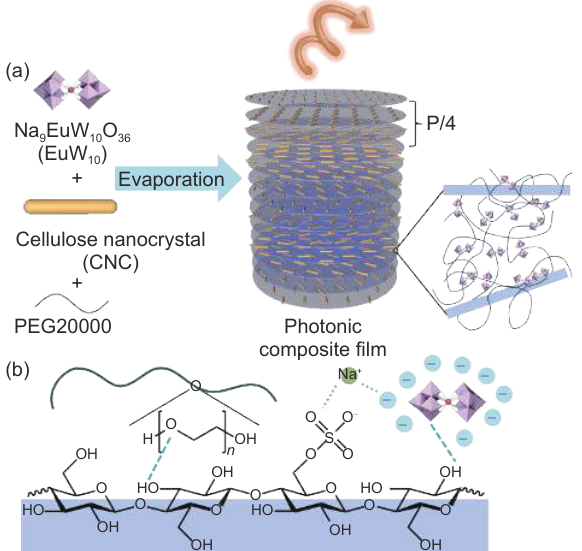
Figure 1 (a) Schematic illustration of CPL composite material based on CNC and EuW 10 and (b) possible formation mechanism of CNC/PEG/EuW 10 (the green dashed line represents electrostatic interaction and the blue dashed line represents hydrogen bond).